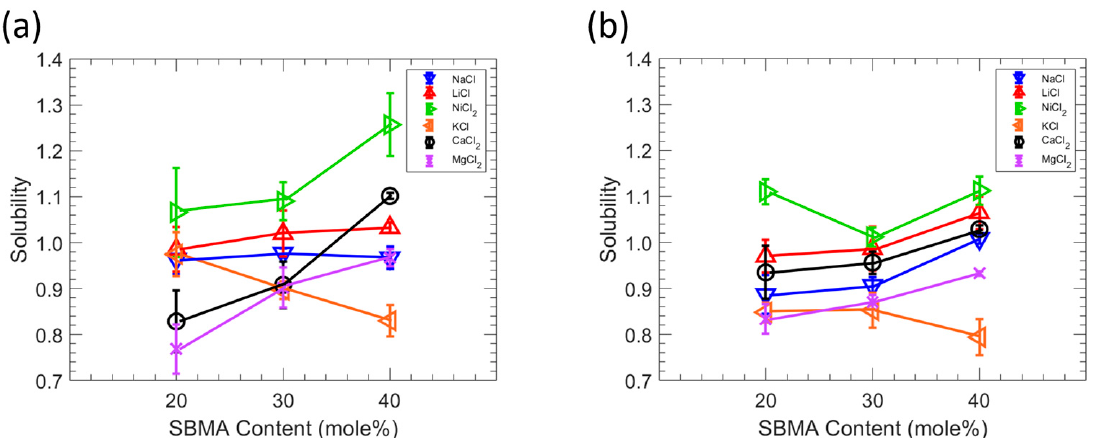
Figure 6. ( a ) Effect of SBMA content on the salt solubility to MBAA 10 films. ( b ) Effect of SBMA content on the salt solubility to MBAA 20 films. The average of three experiments is shown by each data point, and the error bars represent the standard deviation. Lines are guides to the eye.